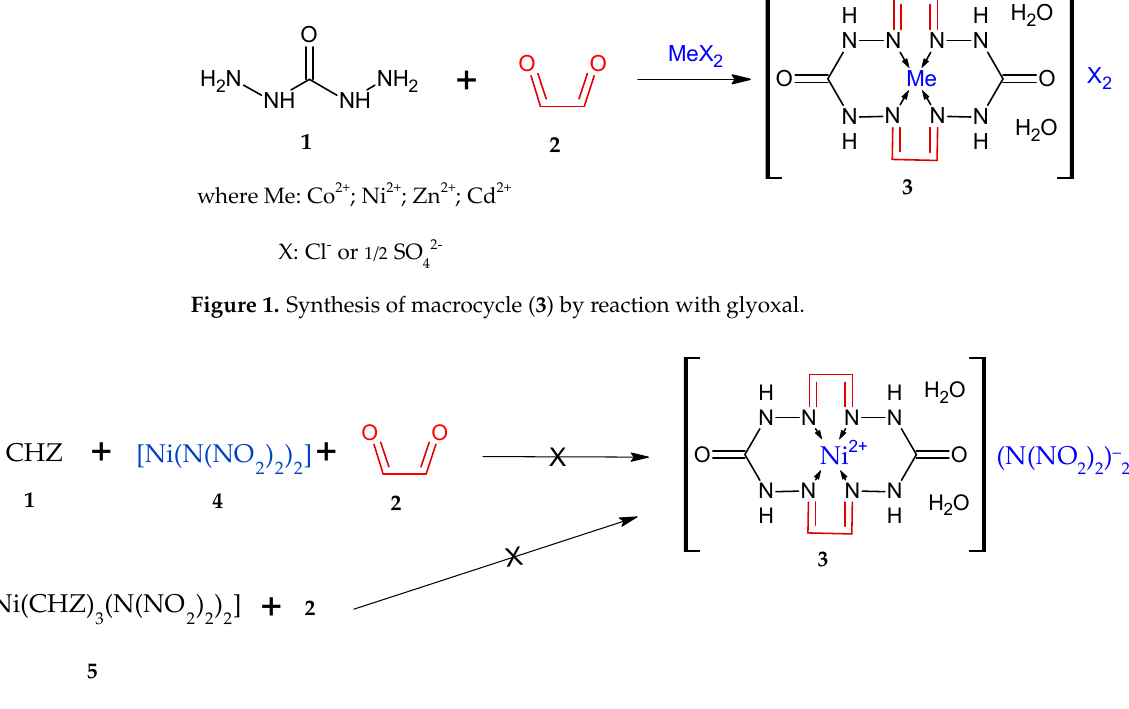
Figure 2. A synthetic scheme for macrocyclic complex 3 in two directions.